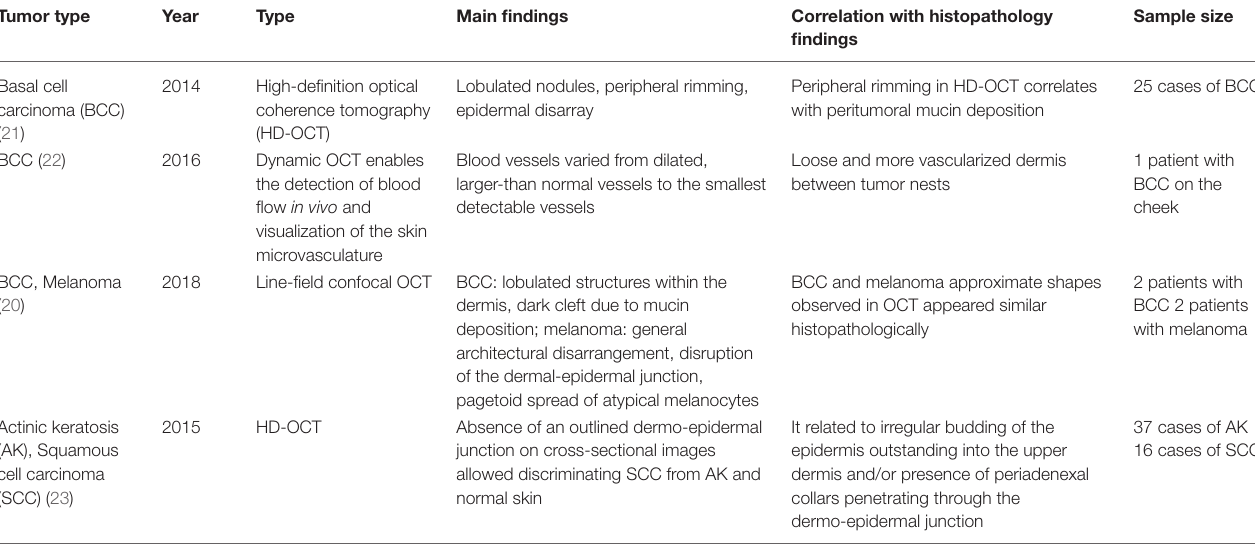
TABLE 4 | Key articles comparing optical coherence tomography and histopathology. Tumor type